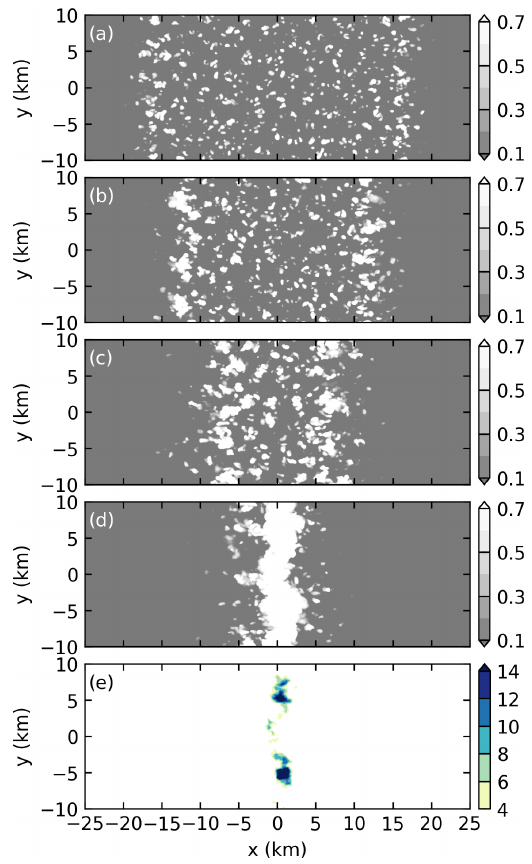
Figure 5. y -averaged (a) cross-coast wind (ms − 1 ), (b) along-coast wind (ms − 1 ), (c) potential temperature (K), (d) vapor mixing ratio (gkg − 1 ), (e) CAPE, and (f) CIN at t = 6h in simulation THF700. The solid lines at x = − 25 and 25km denote the coasts. The dashed lines denote the identified positions of the sea-breeze